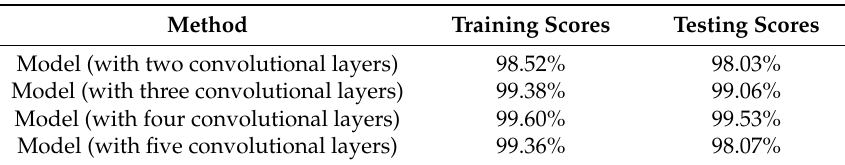
Table 4. Comparison of training and testing scores of the models.